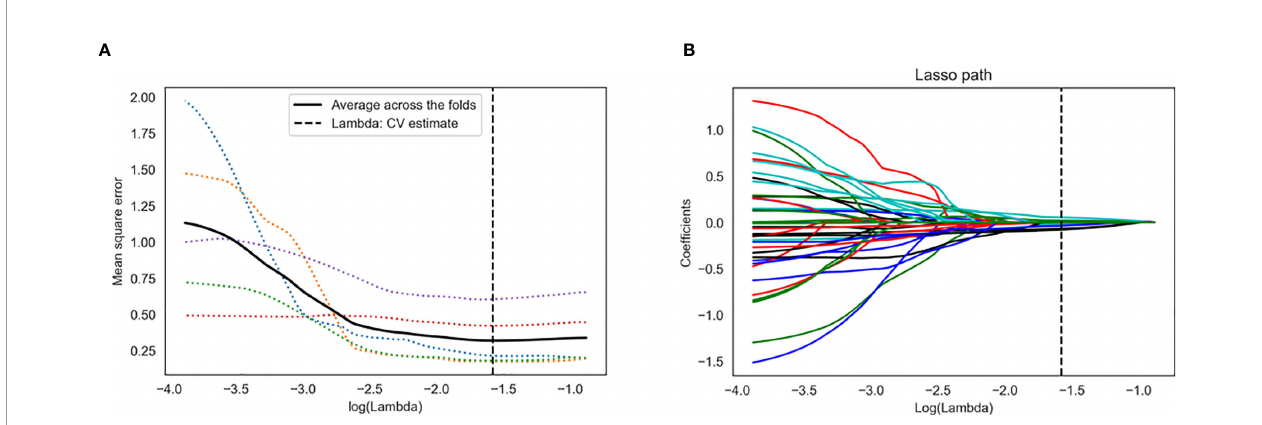
FIGURE 3 | Radiomics feature selection using the least absolute shrinkage and selection operator (LASSO) regression algorithm. (A) Tuning parameter ( l ) selection in LASSO model used fi ve-fold cross-validation via minimum criteria. The y-axis indicates the mean square error. The x-axis indicates the log( l ). The black curve indicates average error for each model with given l . The vertical lines de fi ne the optimal l value of 0.026 with log( l ) = − 1.579 was chosen. (B) LASSO coef fi cient pro fi les of the 38 radiomics features. A coef fi cient pro fi le plot was generated versus the selected log( l ) value using fi ve-fold cross-validation. A vertical line was plotted at the optimal l value, which resulted in seven features with non-zero coef fi cients.